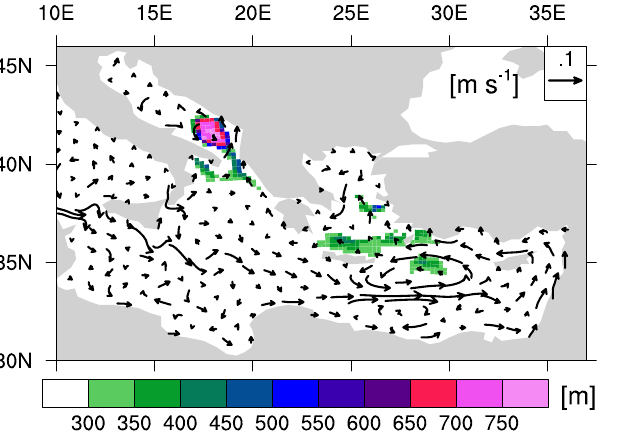
Fig. 2. Sub-basins of the Mediterranean: Gulf of Lion (GL), Alboran Sea (ALB), Tyrrhenian Sea (TYR), Adriatic Sea (ADR), Ionian Sea (ION), Aegean Sea (AEG), Levantine Sea (LEV). The Atlantic box (ATL) and the Black Sea (BS) are shown as well. The main straits are marked with a red star.